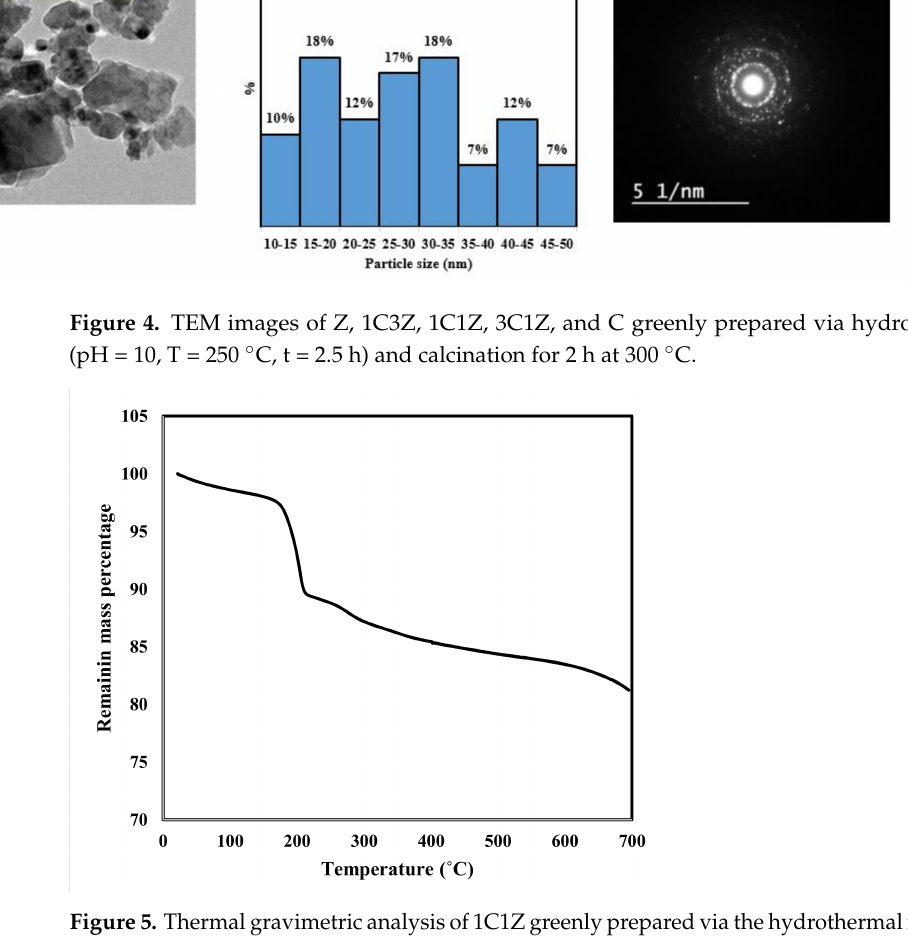
Figure 5. Thermal gravimetric analysis of 1C1Z greenly prepared via the hydrothermal route (pH = 10, T = 250 ◦ C, t = 2.5 h) and calcination for 2 h at 300 ◦ C.